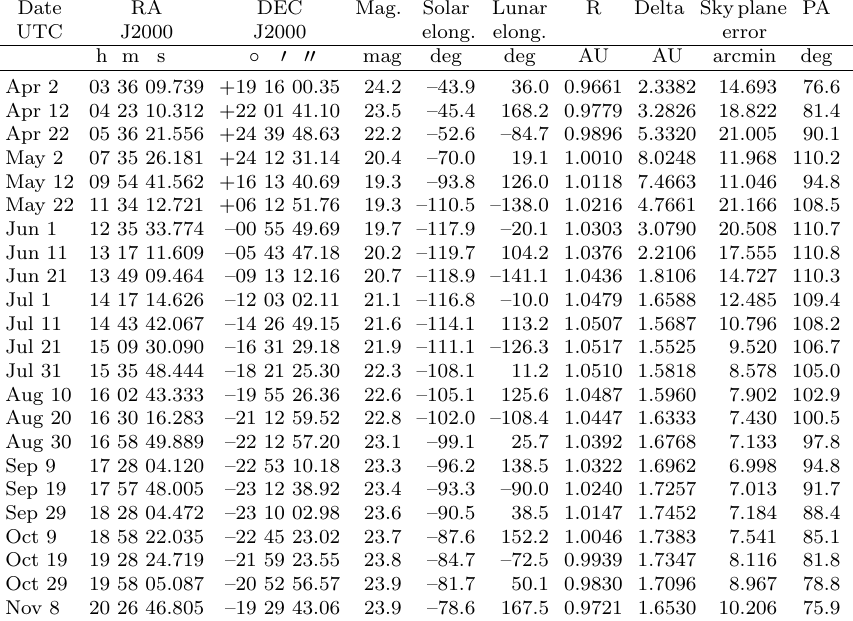
Table 5. Ephemerides of the asteroid 2000 SG344 for its visibility in 2028. The coordinates are given for the geocentric